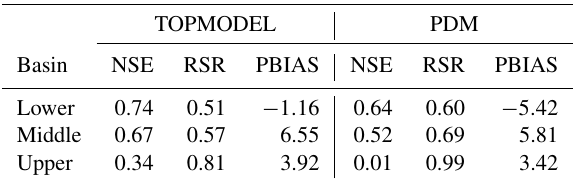
Table 2. Modeling performance as calculated from the observed and modeled flow time series in lower, middle, and upper basins, us- ing (1) TOPMODEL and (2) PDM. NSE: Nash–Sutcliffe efficiency. RSR: RMSE-observation standard deviation ratio. PBIAS: percent- age of bias. TOPMODEL